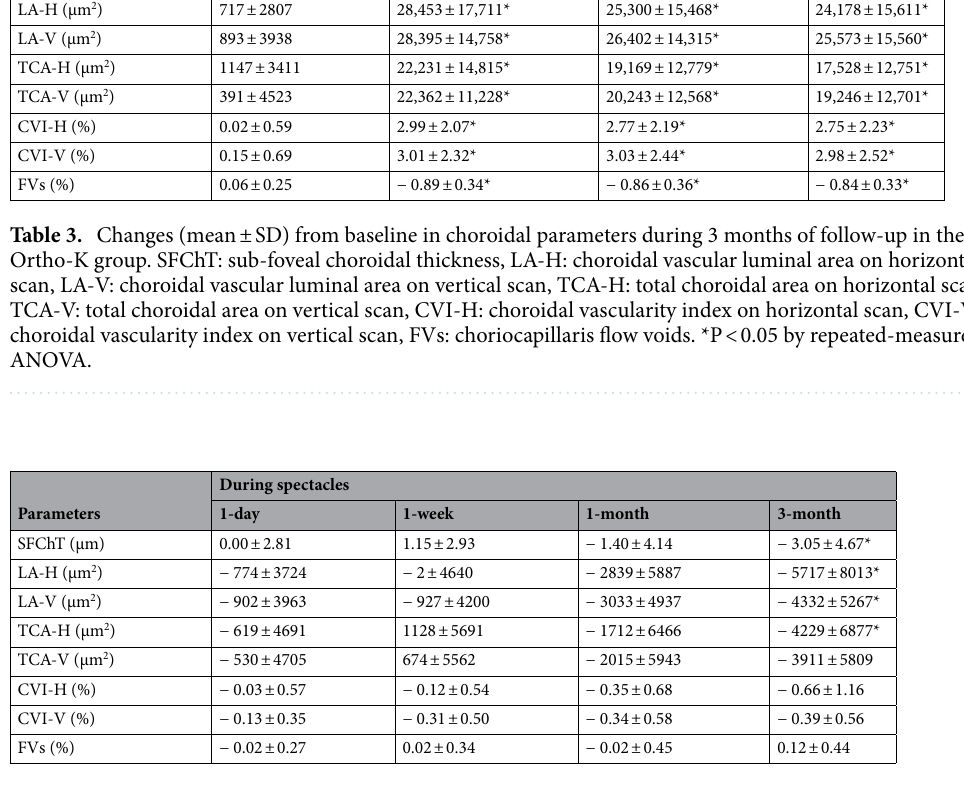
Table 4. Changes (mean ± SD) from baseline in choroidal parameters during 3 months of follow-up in the control group. SFChT: sub-foveal choroidal thickness, LA-H: choroidal vascular luminal area on horizontal scan, LA-V: choroidal vascular luminal area on vertical scan, TCA-H: total choroidal area on horizontal scan, TCA-V: total choroidal area on vertical scan, CVI-H: choroidal vascularity index on horizontal scan, CVI-V: choroidal vascularity index on vertical scan, FVs: choriocapillaris flow voids. * P < 0.05 by repeated-measure ANOVA, or P < 0.005 by Paired sample t test.